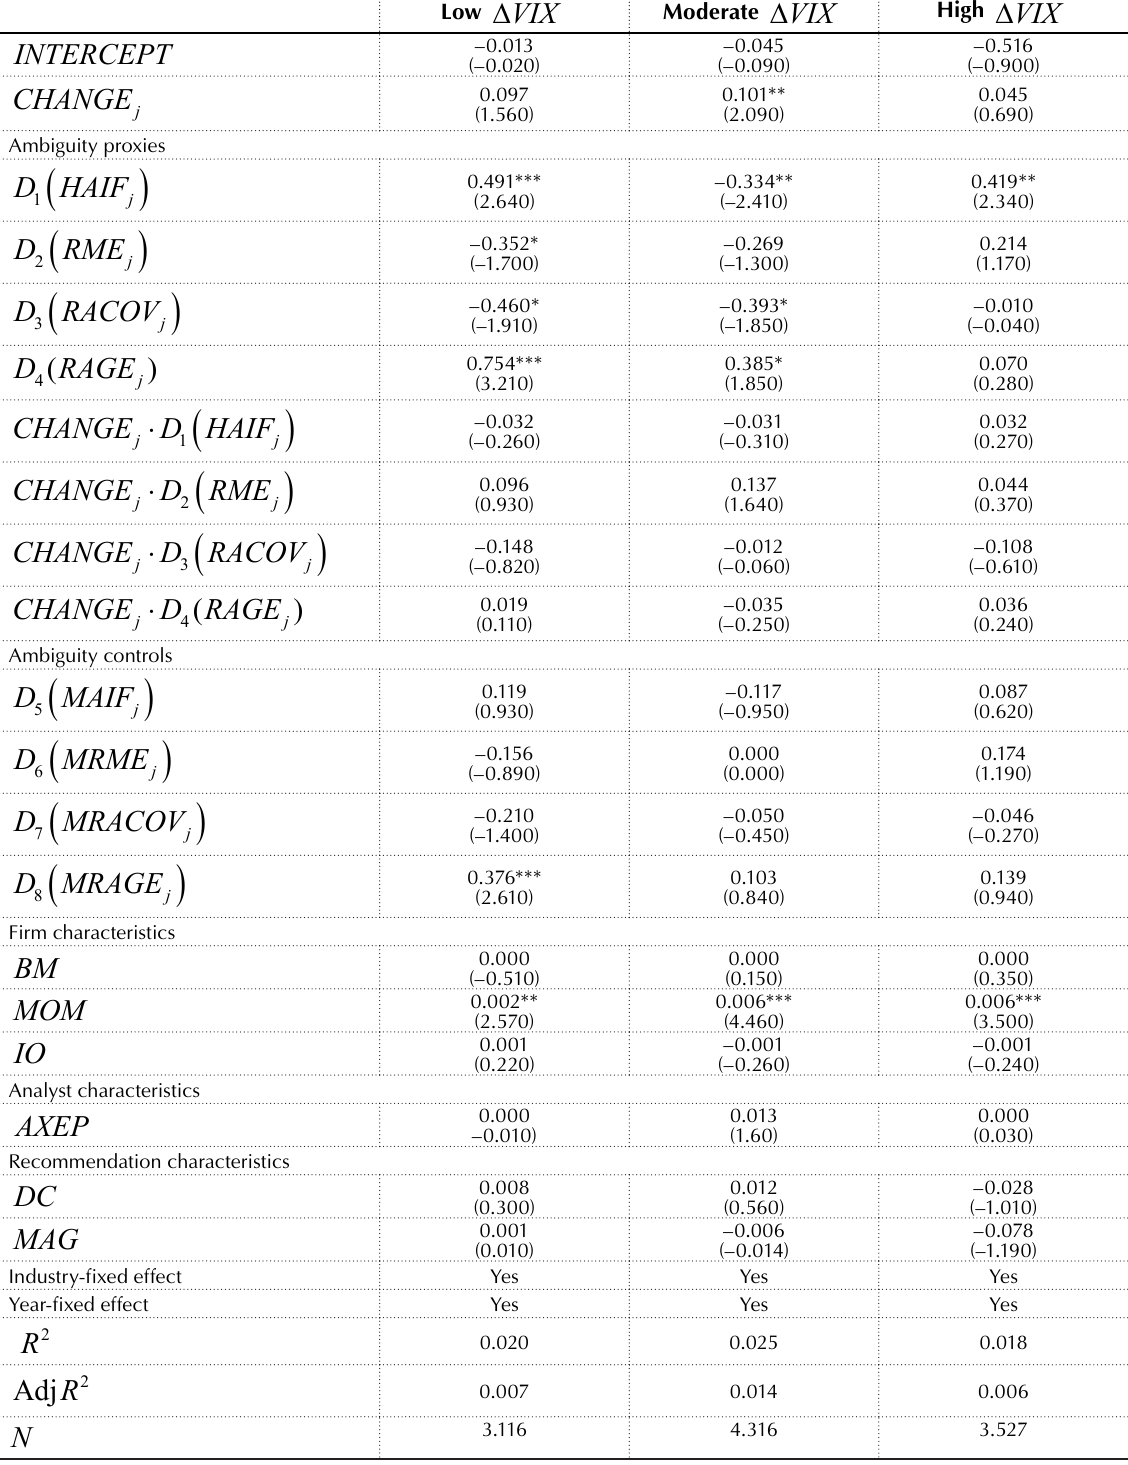
Table 7. The effects of ambiguity in fundamentals and ambiguity in information and on BHARs under different levels of market